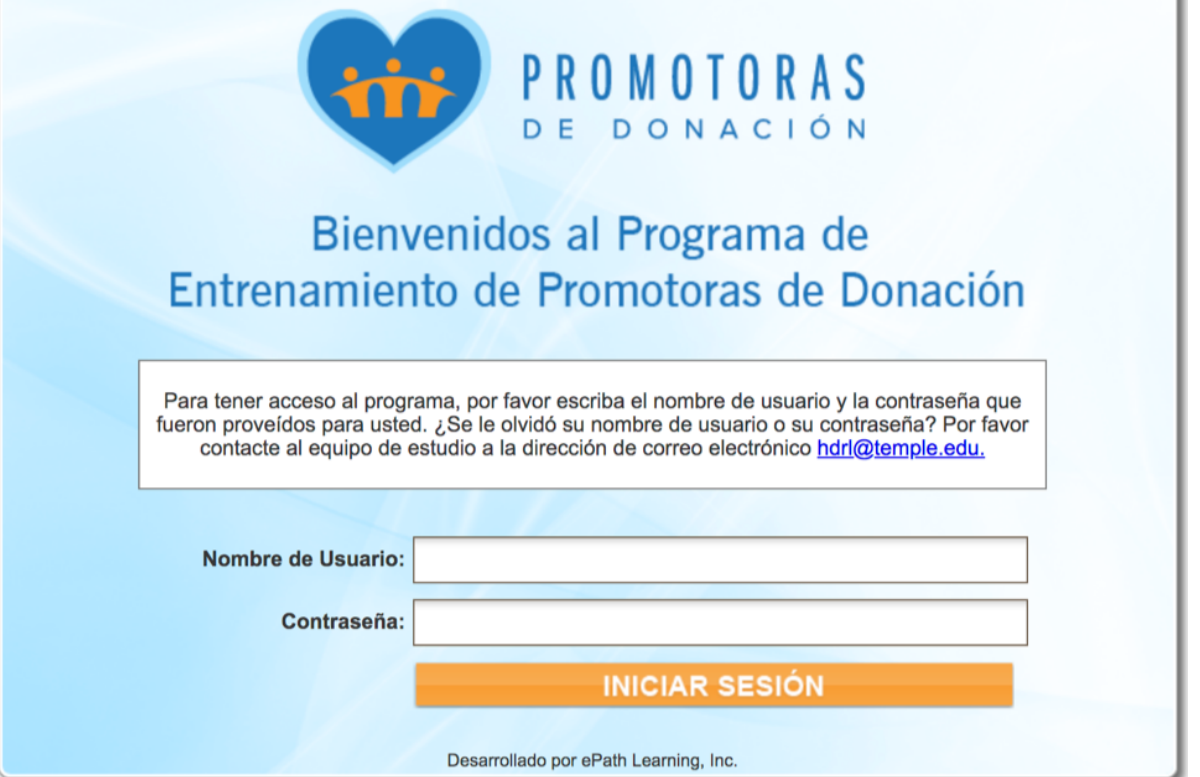
Figure 2. Screenshot of the login page of Promotoras de Donación to illustrate the branding